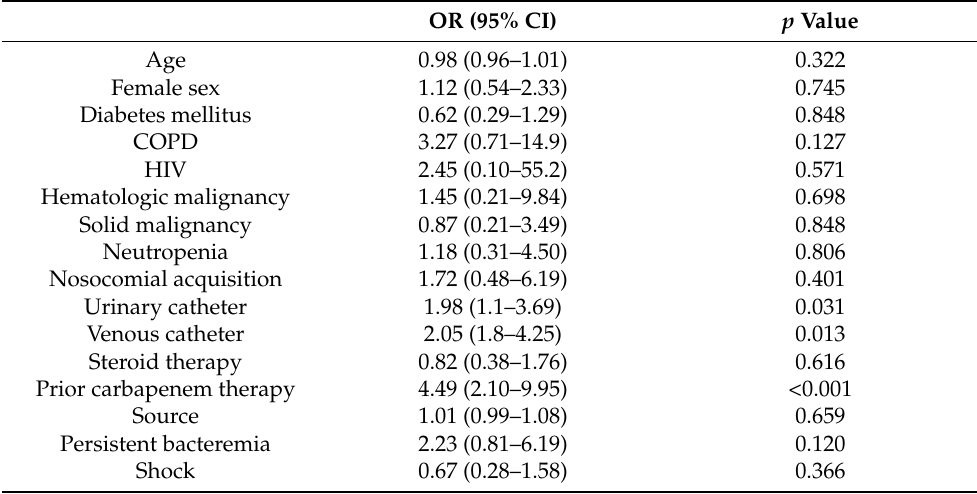
Table 5. Logistic regression model of variables evaluated as predictive factors of carbapenem-resistant Pseudomonas aeruginosa bloodstream infection in solid organ transplant